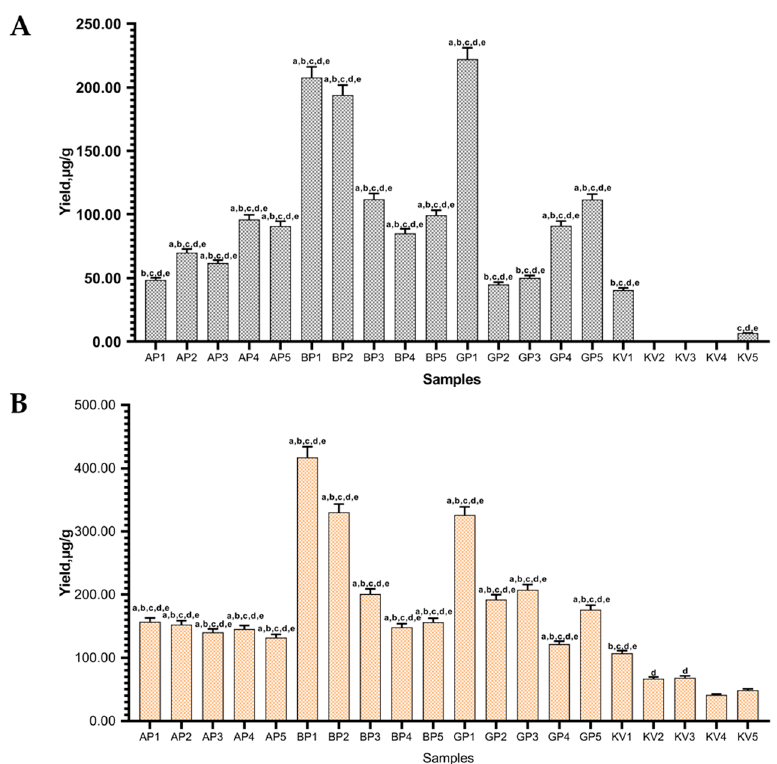
Figure 5. Quantitative yield of ( A ) genistein and ( B ) daidzein using excipients (5%). Control samples without excipients (KV1-5), samples with α -CD (AP1-5), β -CD (BP1-5), γ -CD (GP1-5). a p < 0.05 vs. KV1, b p < 0.05 vs. KV2, c p < 0.05 vs. KV3, d p < 0.05 vs. KV4, e p < 0.05 vs. KV5. Sample codes are